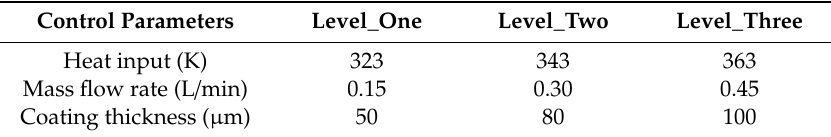
Table 1. Parameters for control (Design factors) and their Levels.